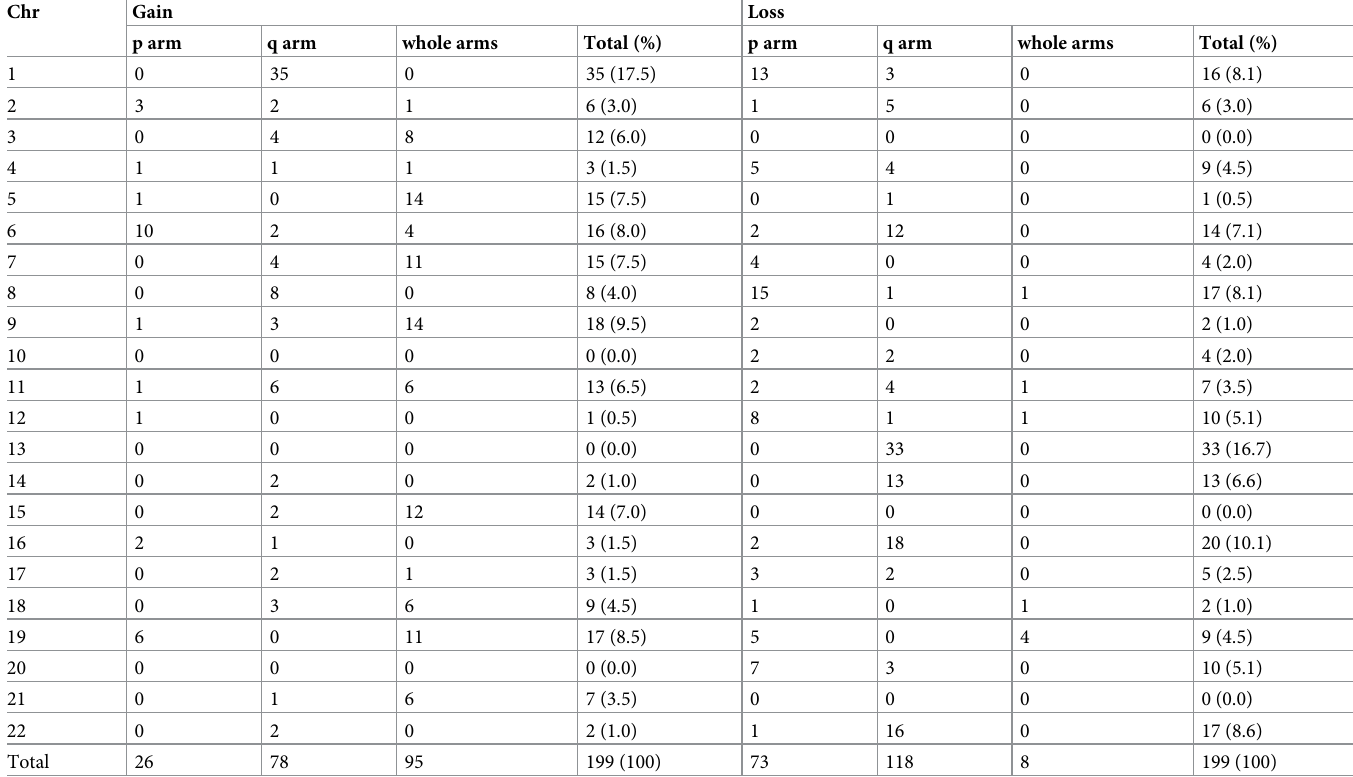
Table 2. Frequency of copy number alterations in patients with newly diagnosed multiple